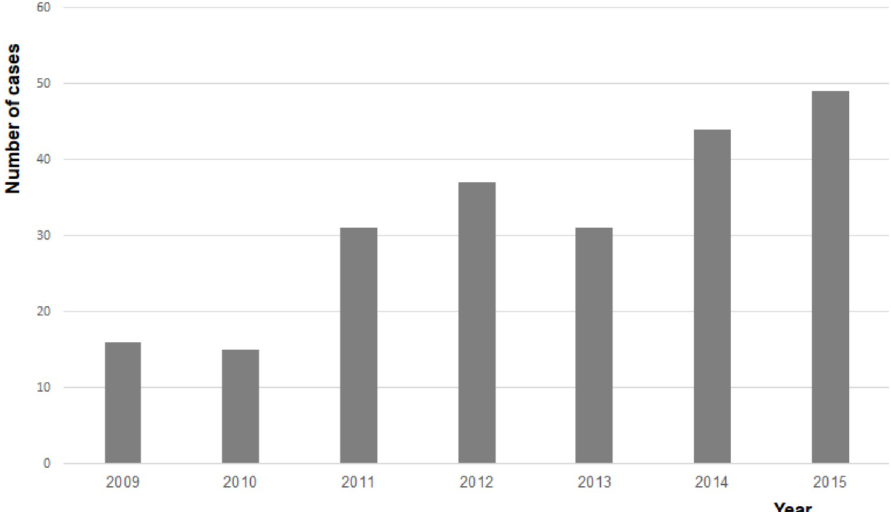
Fig 1. Number of cases per year. The annual number of cases of Acanthamoeba keratitis in the